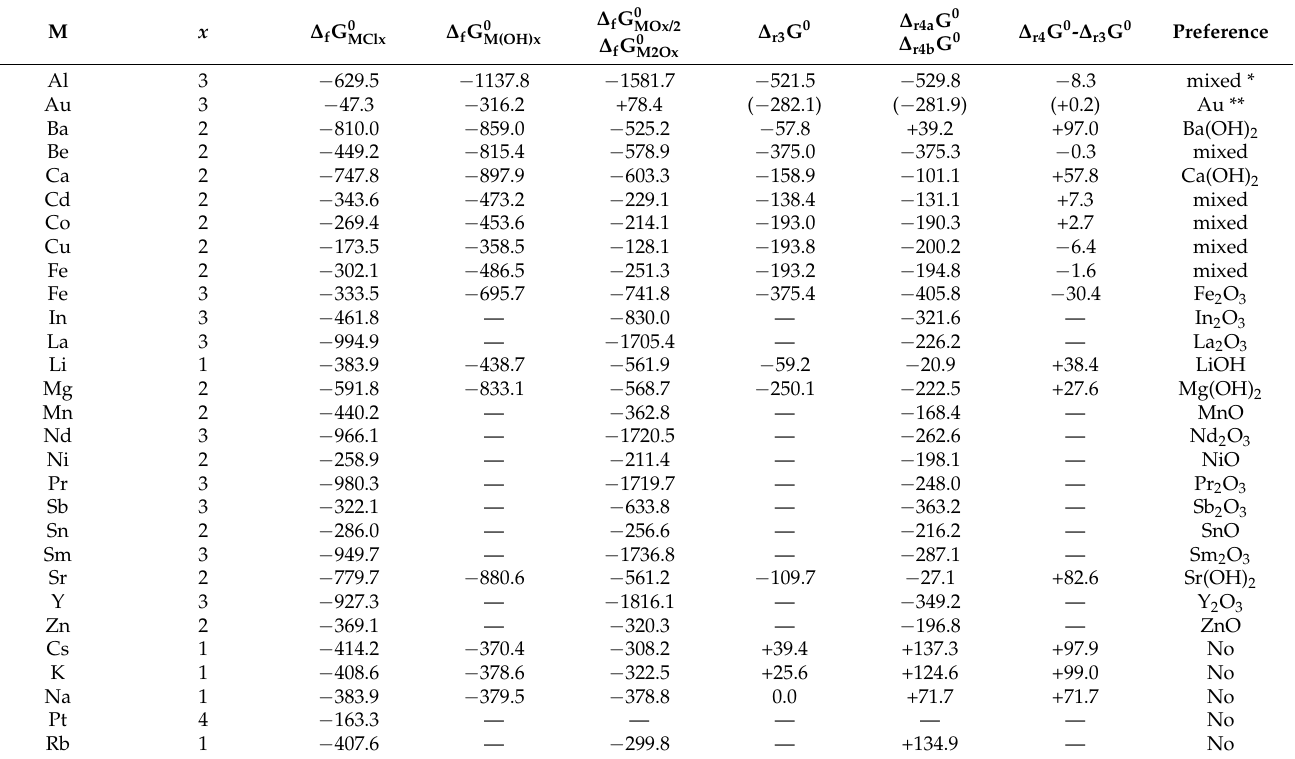
Table 3. Results of calculations by Equations (6)–(8) at T = 300 K (all values are in kJ/mol-MCl x